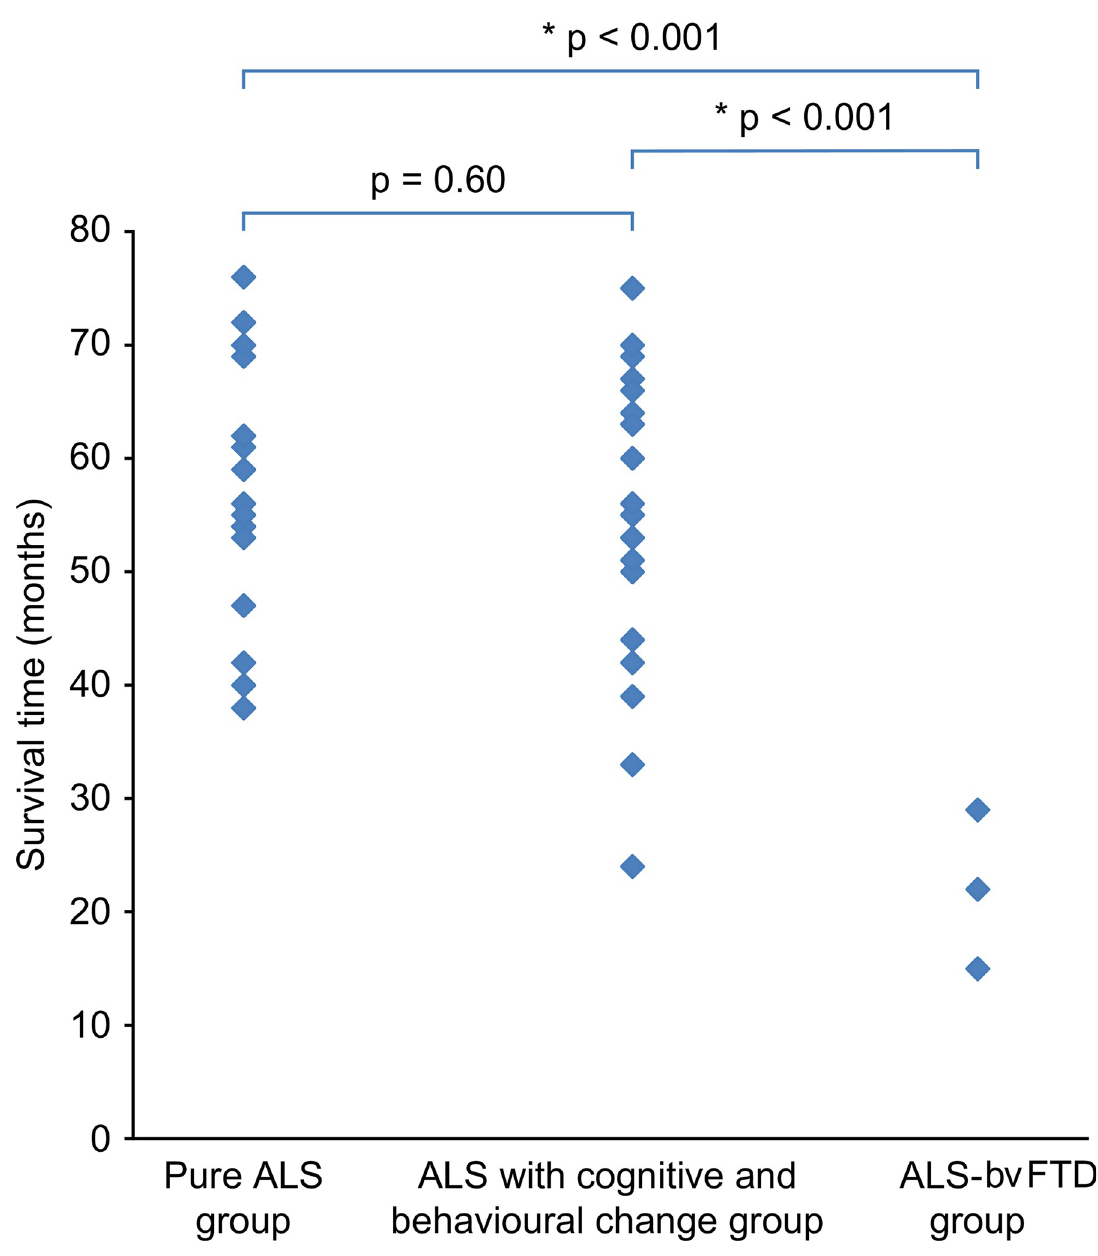
Fig 3. Comparison of survival time among